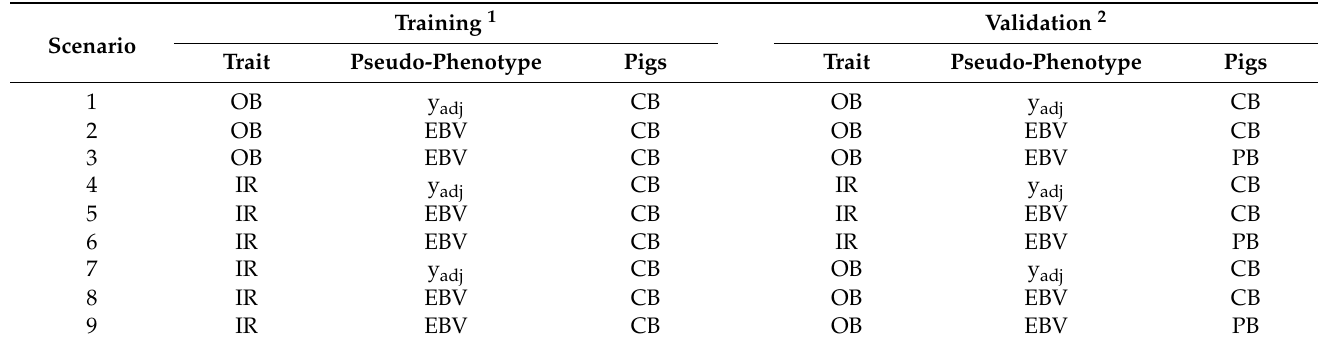
Table 1. Training-validation scenarios used for the genomic regression